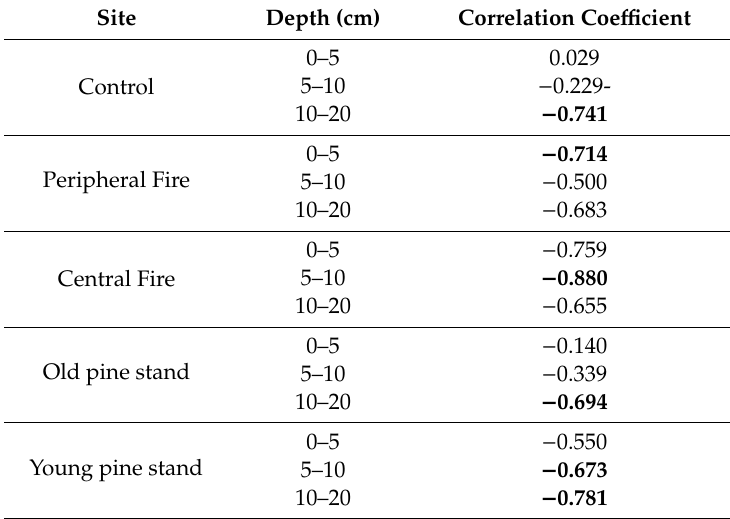
Table 3. Spearman’s rank correlation coe ffi cients between SWR (median WDPT test value) and the soil moisture content divided into the level of factors (depths and sampling sites and divided into depths and ages of the pine stand). Statistically significant values are in